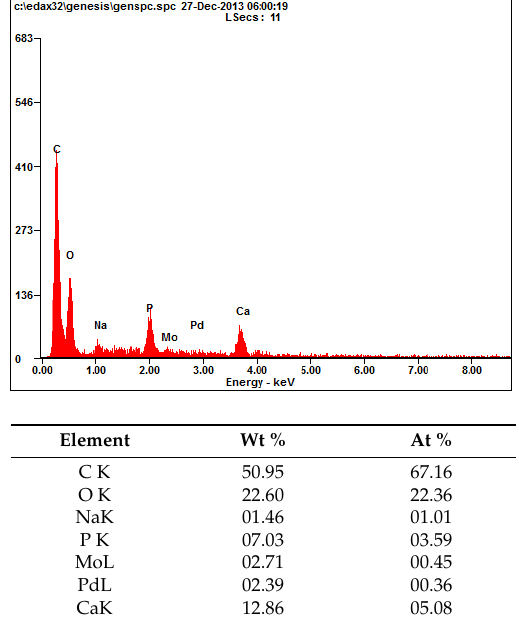
Figure 2. Energy dispersive spectrometry (EDS) of the hydroxyapatite/β-tricalcium phosphate-collagen composite.